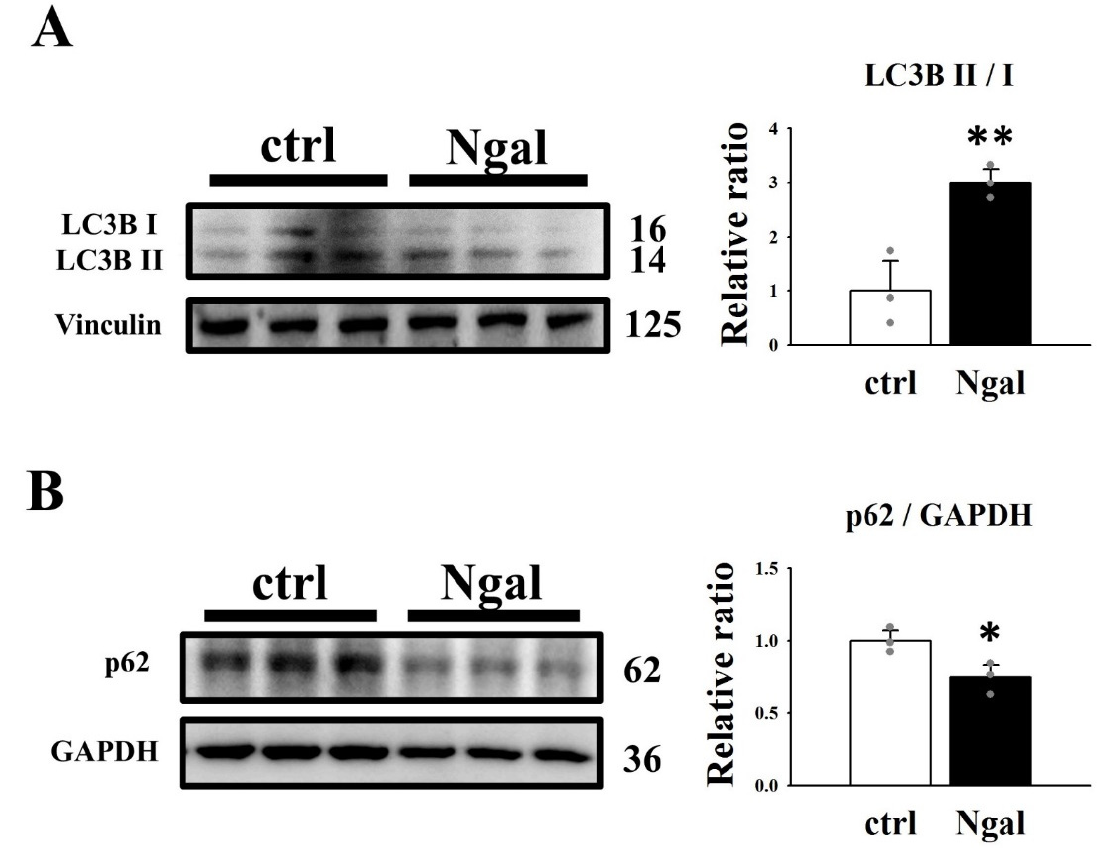
Figure 5. Effects of mNGAL on autophagy in 2L3 cells. Western blot results showed that mNGAL treatment for 24 h increased the autophagy-representing markers, LC3B II/LC3B I ( A ) and p62 ( B ) in 2L3 cells. Vinculin and GAPDH were used as the internal control of each sample. Values were normalized to the control group. Student’s t- test was performed to determine the significance between groups ( n = 3). * p < 0.05; ** p < 0.01 vs. control group.